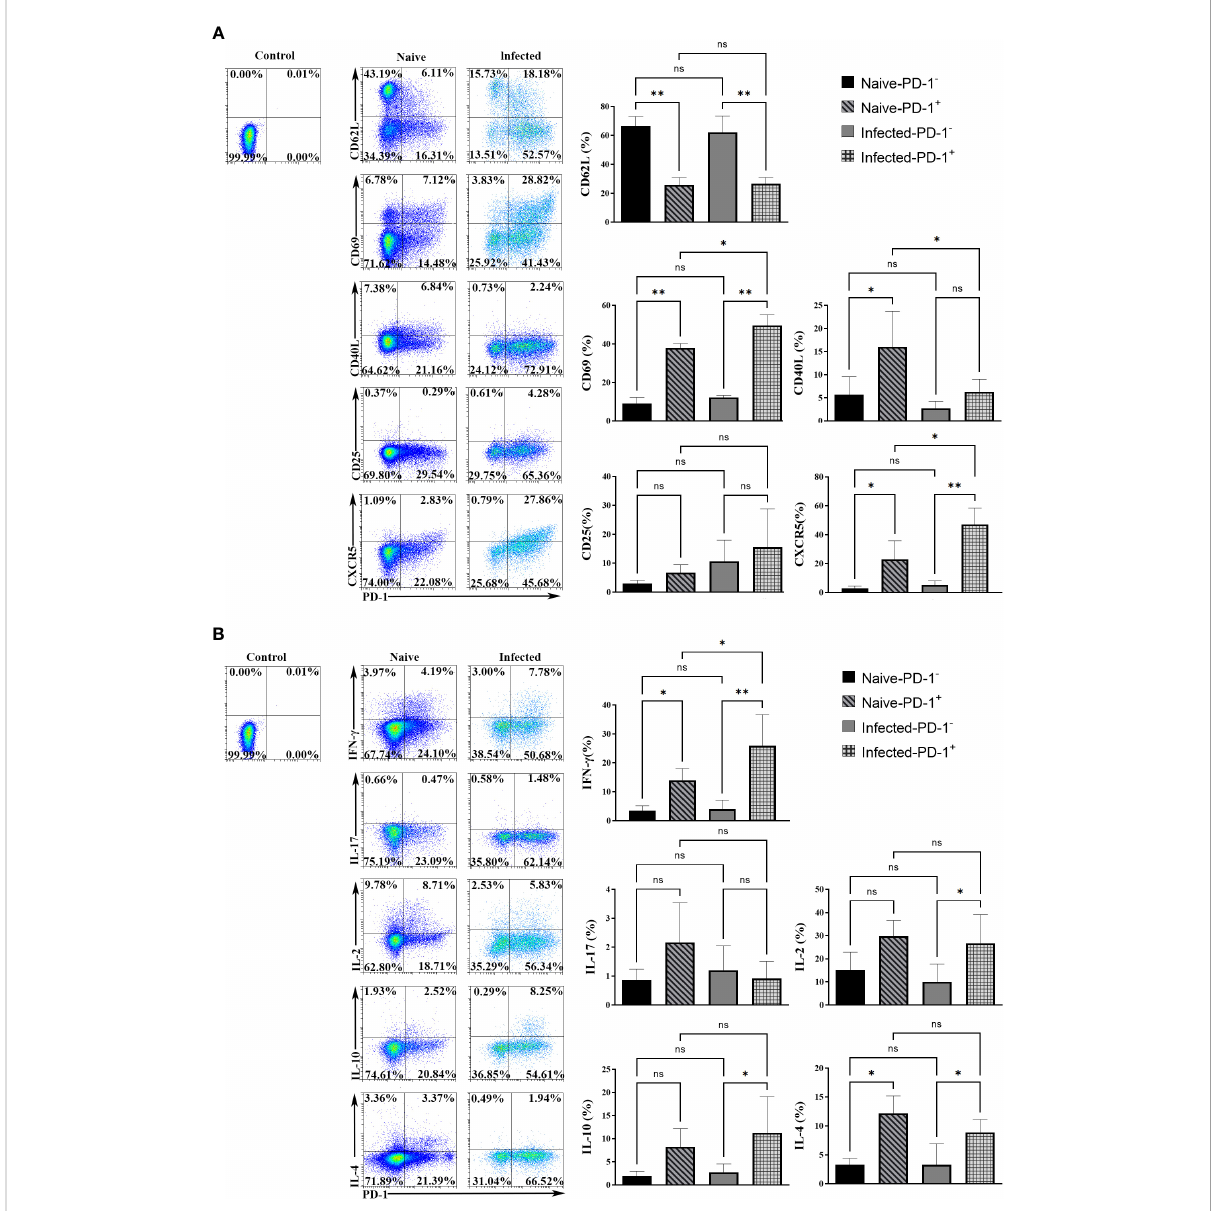
FIGURE 2 The surface markers and cytokines in PD-1 + CD4 T cells were changed upon P. yoelii infection. (A) single splenic lymphocytes were stained with fl uorescent antibodies: PD-1, CD4, CD62L, CD69, CD40L, CD25, and CXCR5. The isotype controls were set. The expression of surface markers from different groups was compared. (B) the single splenic lymphocytes incubated with fl uorescent antibodies: CD4, PD-1, IL-2, IFN- g , IL-10, IL- 17, IL-4. The isotype controls were set. The secreting ability of cytokines from different groups was compared. 3 – 7 samples were prepared for each group, and the experiments were repeated three times. The error bars represented number of mice. * p <0.05, ** p <0.01. ns, no statistical signi fi